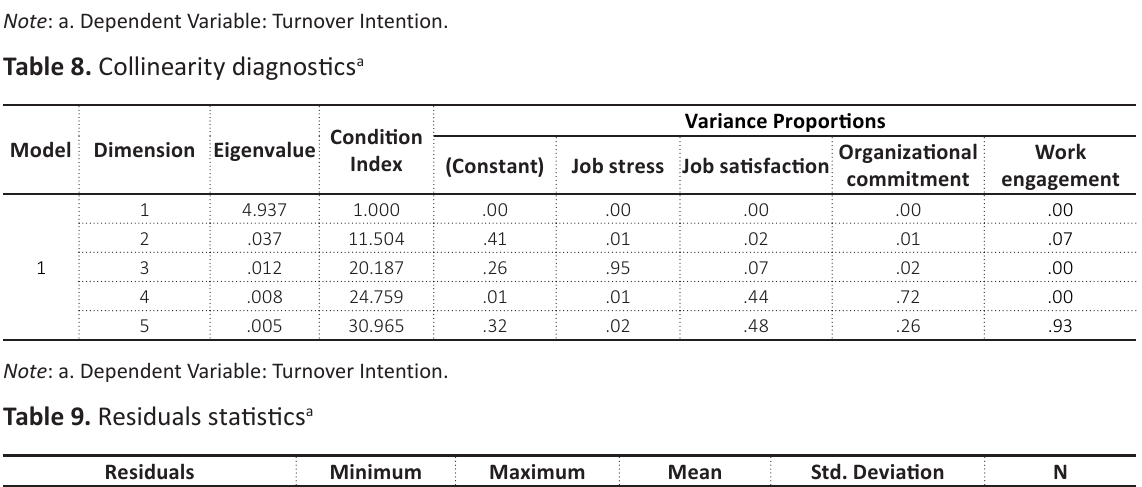
Table 8. Collinearity diagnostics a